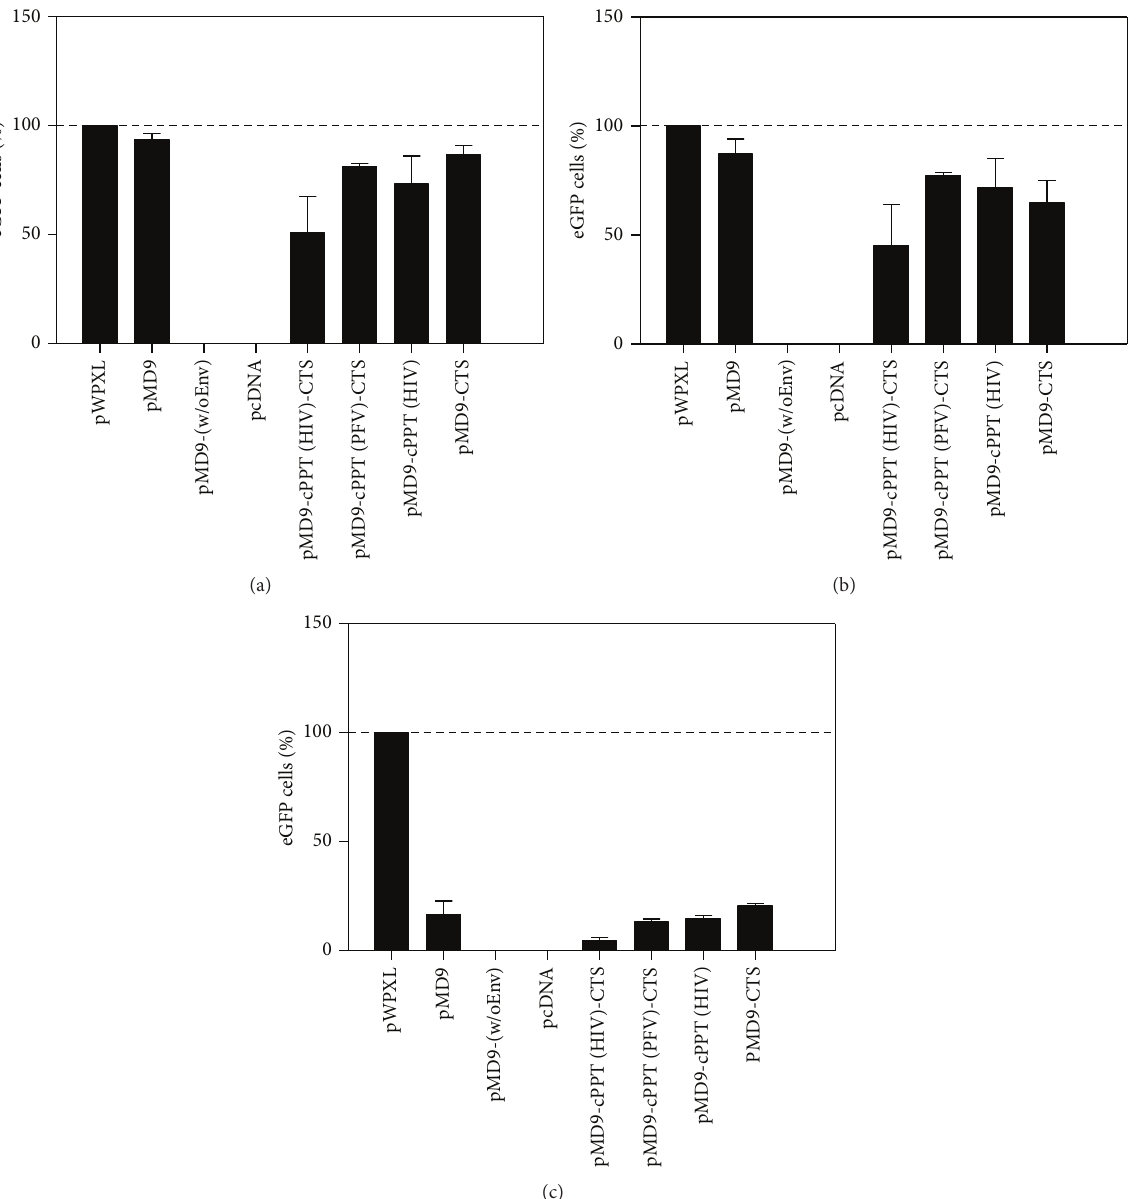
Figure 4: The summarized statistics of retroviral replication efficiency (transduction rate) in the A549 cells. The pMD9-based plasmids were tested to efficiently transduce dividing and growth-arrested cells (G 1 /S phase of cell cycle). Three conditions were analysed in the